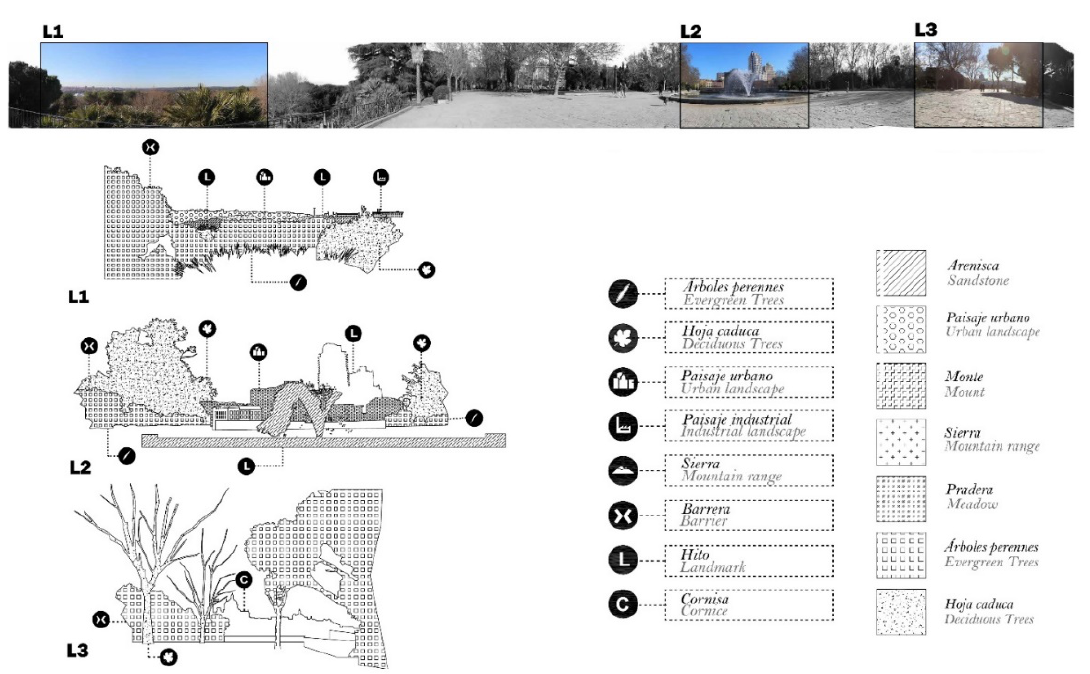
Figure 8: Panorama, selected frames and interpretive drawings from ‘Temple of Debod’